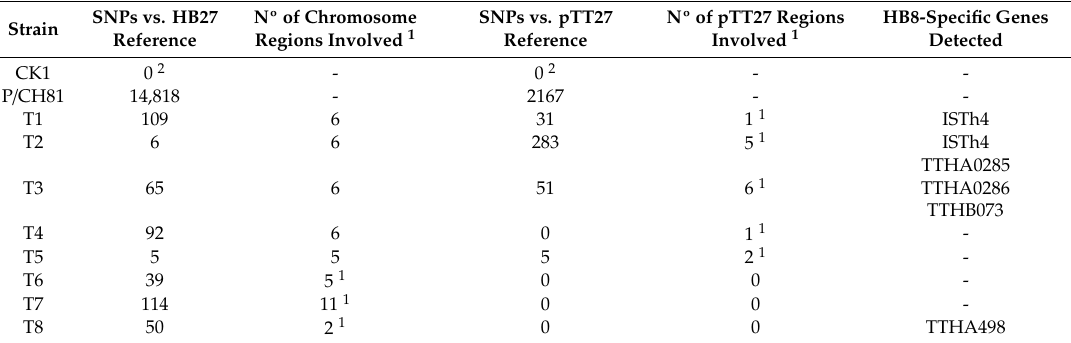
Table 3. Parenthood analysis of transjugants T1–T8. Number of specific single nucleotide polymorphisms (SNPs) found both in the HB8 strain and transjugants T1 to T8 with respect to the HB27 chromosome and megaplasmid reference and number of regions